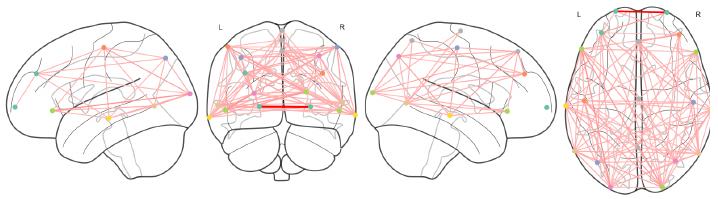
Figure 4. Network representation for PPA group, including nodes, connections and their strength in alpha frequency